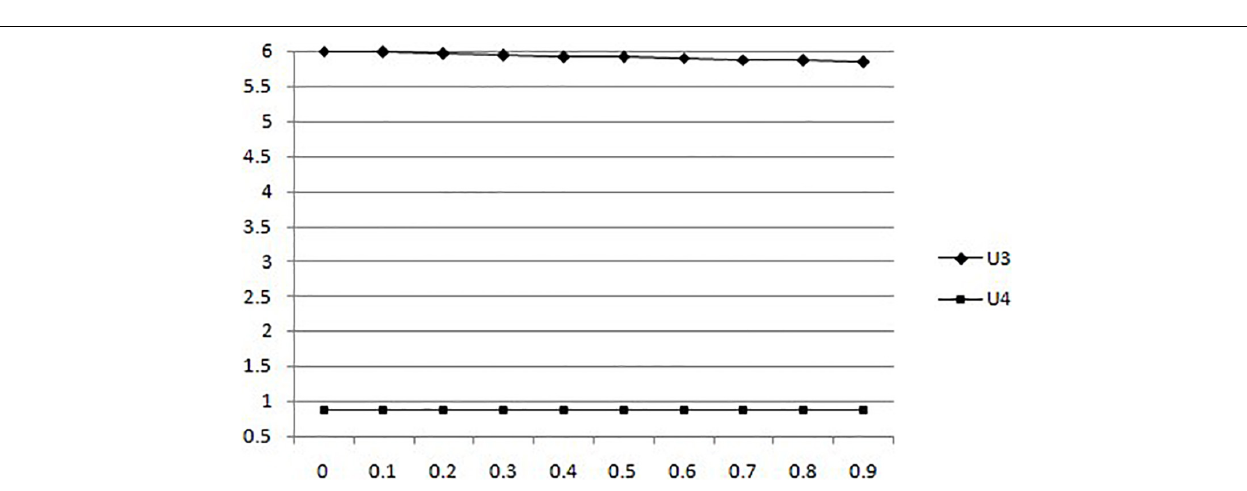
FIGURE 3 | In the absence of government intervention, the expected utility of mobile medical businesses and users changes with users’ choice of filtering information.